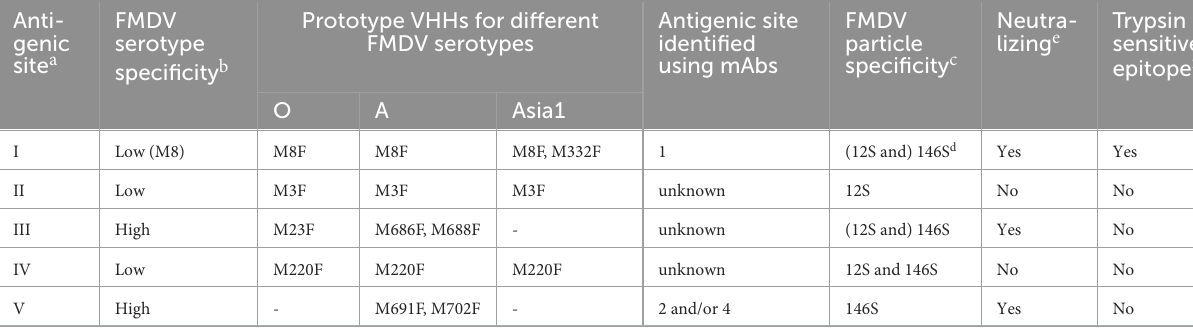
TABLE 2 Characteristics of antigenic sites recognized by VHHs. Anti- genic